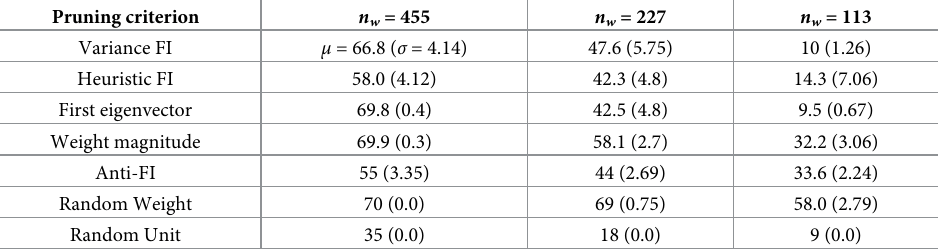
Table 1. Differences in numbers of remaining hidden units. Each table entry contains the mean “ μ ” number of hid- den neurons n h after each pruning iteration, and their standard deviation ( σ ) in parenthesis. The results were averaged over 10 simulations. The model initially had n pruning iterations half of the weights were removed according to different criteria. n w describes the remaining weights at the given phase of pruning.